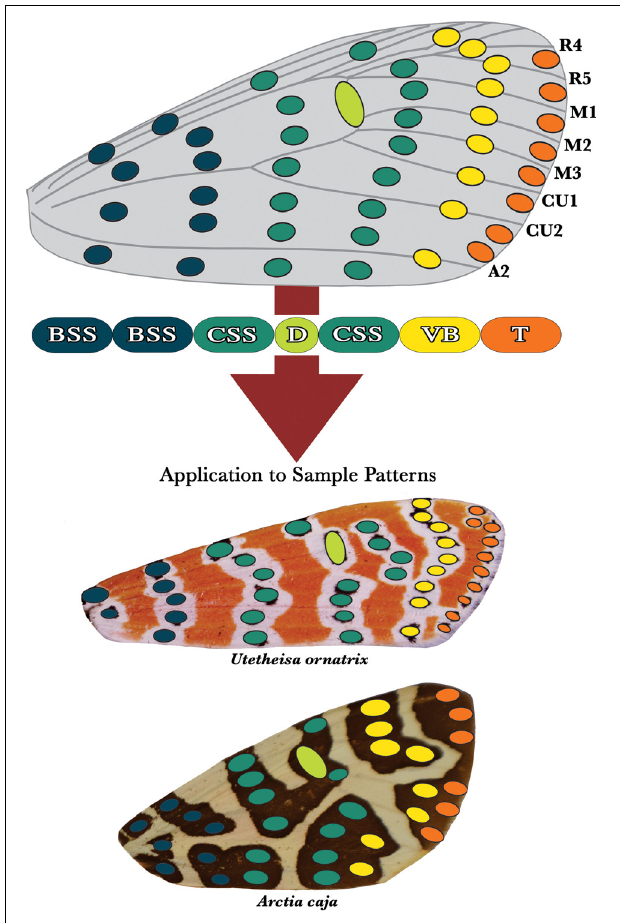
FIGURE 5 | The arctiid archetype. We hypothesize that arctiid moth dorsal forewing patterns are fundamentally composed of serially repeated spotted elements arranged in columns that run anterior-posterior across the wing’s surface. The development of certain columns of spots is predicted to be highly correlated, leading to the formation of a series of five individuated characters: the (1) basal symmetry system (BSS), (2) central symmetry system (CSS), (3) discal spot (D), (4) van Bemmelen band (VB), and (5) terminal band (T). As with the butterflies, the two columns nearest to the wing hinge are hypothesized to constitute the basal symmetry system (blue). The central symmetry system (green) is composed of two columns of spots that are positioned immediately distal to the BSS. The columns of spots that compose this character lie on either side of the discal spot (lime), which is located directly on top of the discalis cross-vein. The van Bemmelen band (yellow) has no counterpart in the dorsal forewing patterns of the butterflies, and could be unique to the arctiids. The terminal band (orange) is located on the wing’s distal margin, and consists of a series of spots positioned directly between the vein termini. At the bottom of the figure, the arctiitype has been applied to the patterns of two sample tiger moth species, Utetheisa ornatrix and Arctia caja . column) that can be located directly on top of the wing veins (Gawne and Nijhout, 2019). The final character shown on the arctiid archetype is the terminal band, which generally consists of a series of semi-discrete spots that are positioned between the vein termini along the wing’s distal margin. The basal and central symmetry systems shown on the arctiitype are likely homologs of their counterparts on